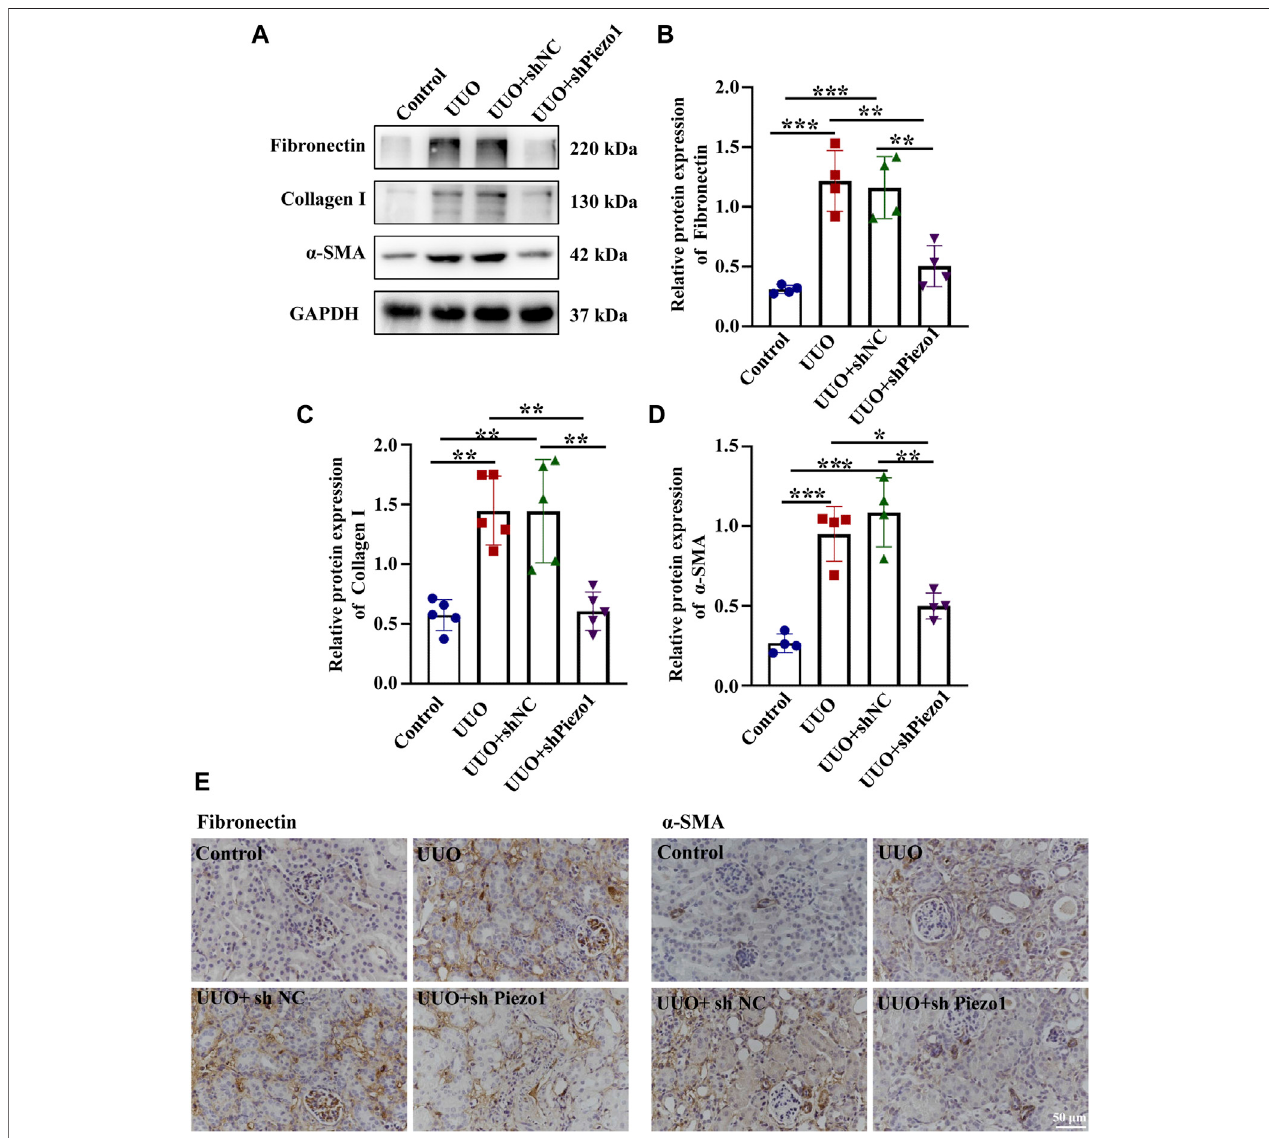
FIGURE9| Piezo1knockdown reducestheexpression ofECMproteinlevelsinUUOmice.Ananimalmodelofrenal fi brosisinducedbyUUO wasestablished and a loss-of-function experiment was carried out by using shRNA of Piezo1 and shNC in UUO mice. (A) Representative western blot bands show the protein expression of Fibronectin, CollagenIand α -SMAinthefour differenttreatmentgroups. Thebar graph showsthe resultofsemi-quantitativemeasurementofFibronectin (B) ,CollagenI (C) and α -SMA (D) . ( n (cid:1) 4; * p < 0.05, ** p < 0.01, *** p < 0.001). (E) Representative photomicrographs show immunohistochemical staining with Fibronectin and α -SMA after Piezo1 knockdown in UUO mice. scale bar indicates 50 μ m.